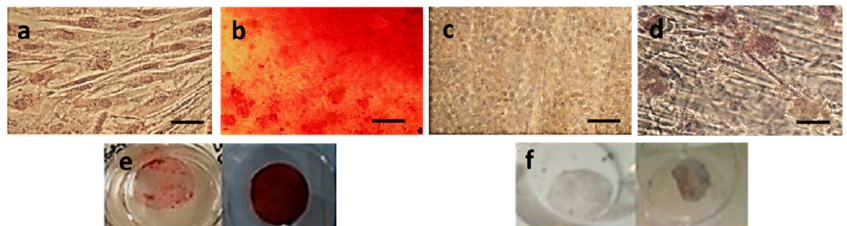
Figure 6. Alizarin red staining of ( a ) Mesenchymal cells on PMMA-HEMA surfaces that were used as the control (absence of 2). ( b ) Differentiated mesenchymal cells into osteoblasts on biofunctionalized PMMA-HEMA surfaces (immobilized 5). Alkaline phosphatase activity of ( c ) Mesenchymal cells used as control after alkaline phosphatase staining on PMMA-HEMA surfaces that were untreated differentiated mesenchymal cells into osteoblasts after culturing on PMMA-HEMA surfaces. ( d ) Immobilized 5 maintains its ability to enhance the differentiation process. ( e ) Differentiated mesenchymal cells into osteoblasts on biofunctionalized PMMA-HEMA surfaces (immobilized 5). ( f ) Samples of the surfaces used for alizarin red staining (Left: Mesenchymal cells on PMMA-HEMA surface used as control. Right: Mesenchymal cells on biofunctionalized PMMA-HEMA surface stained positively). ( f ) Samples of the surfaces used for alizarin red staining assay (Left: Mesenchymal cells on control PMMA-HEMA surfaces that were not differentiated into osteoblasts. Right: Reprogrammed mesenchymal cells stained for alkaline phosphatase on biofunctionalized PMMA-HEMA surfaces).